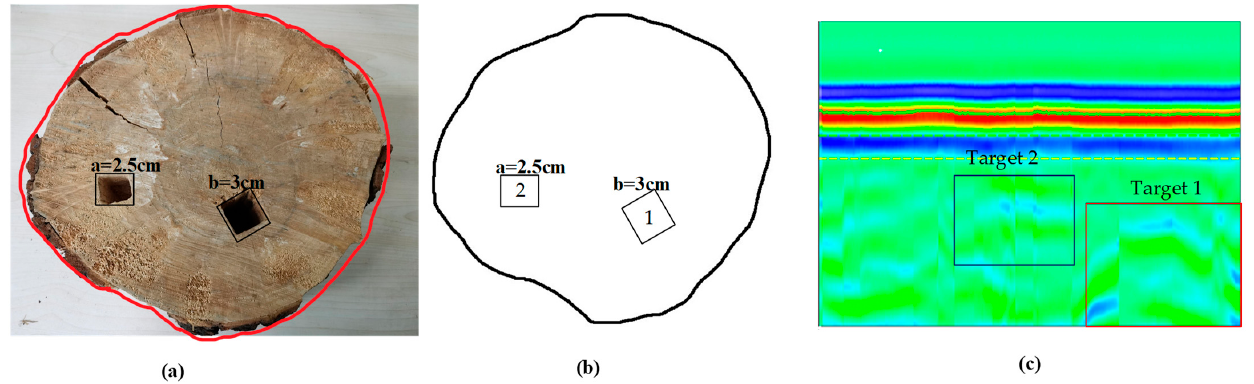
Figure 7. Investigation of irregular willow tree stump. ( a ) Image of the irregular stump; the red curve is the irregular detection route. ( b ) Outer contour and defects of the irregular stump. ( c ) Radar reflection image of the irregular stump; the rectangular box is the reflection curve of the target.